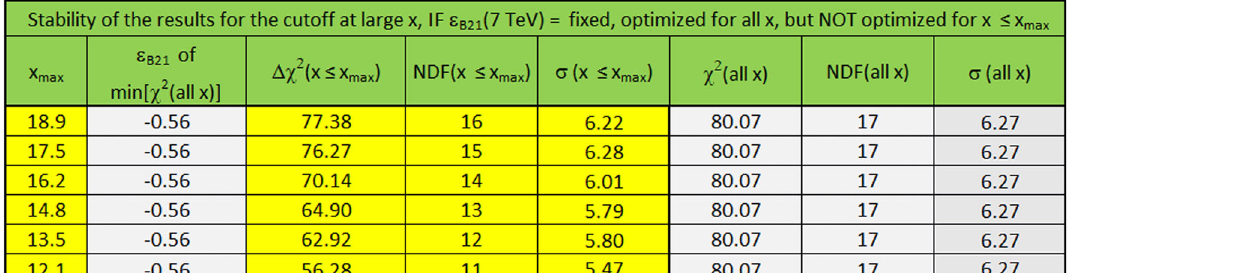
Table8 StabilityoftheOdderonsignalonthevariation x max ,theupper √ s = 7 TeV limit of the domain of validity of the H ( x ) scaling using √ s = 1 . 96 TeV D0 p ¯ p data in x = − tB TOTEM pp data projected to